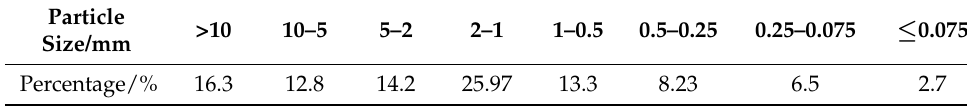
Table 1. Particle size distribution of the tested soils.